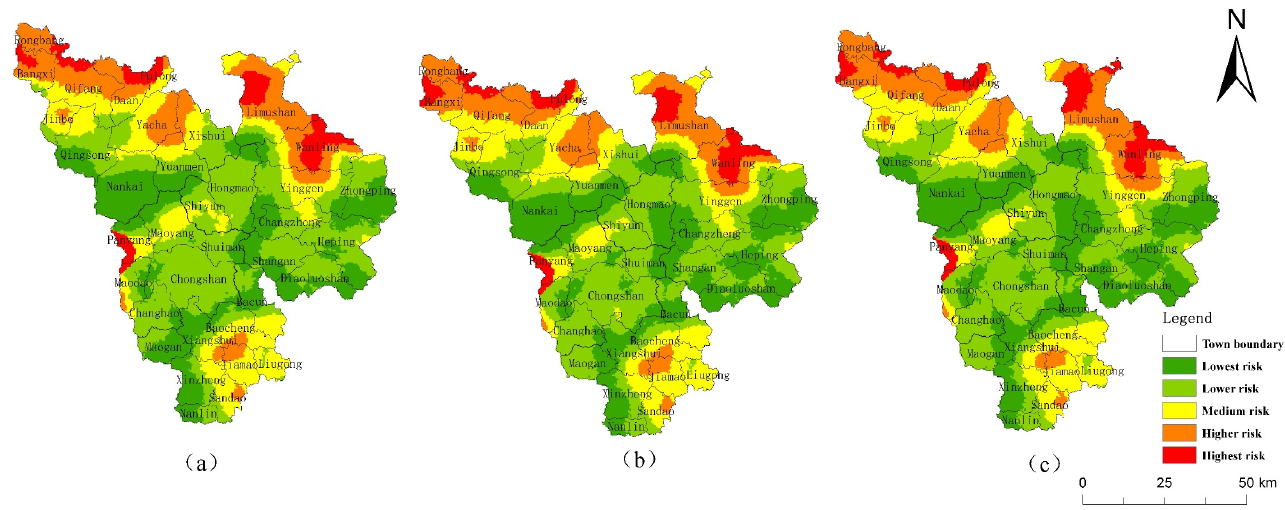
Figure 4. Spatial distribution of landscape ecological risk in the CMA. ( a ) 2000, ( b ) 2010, ( c ) 2018.